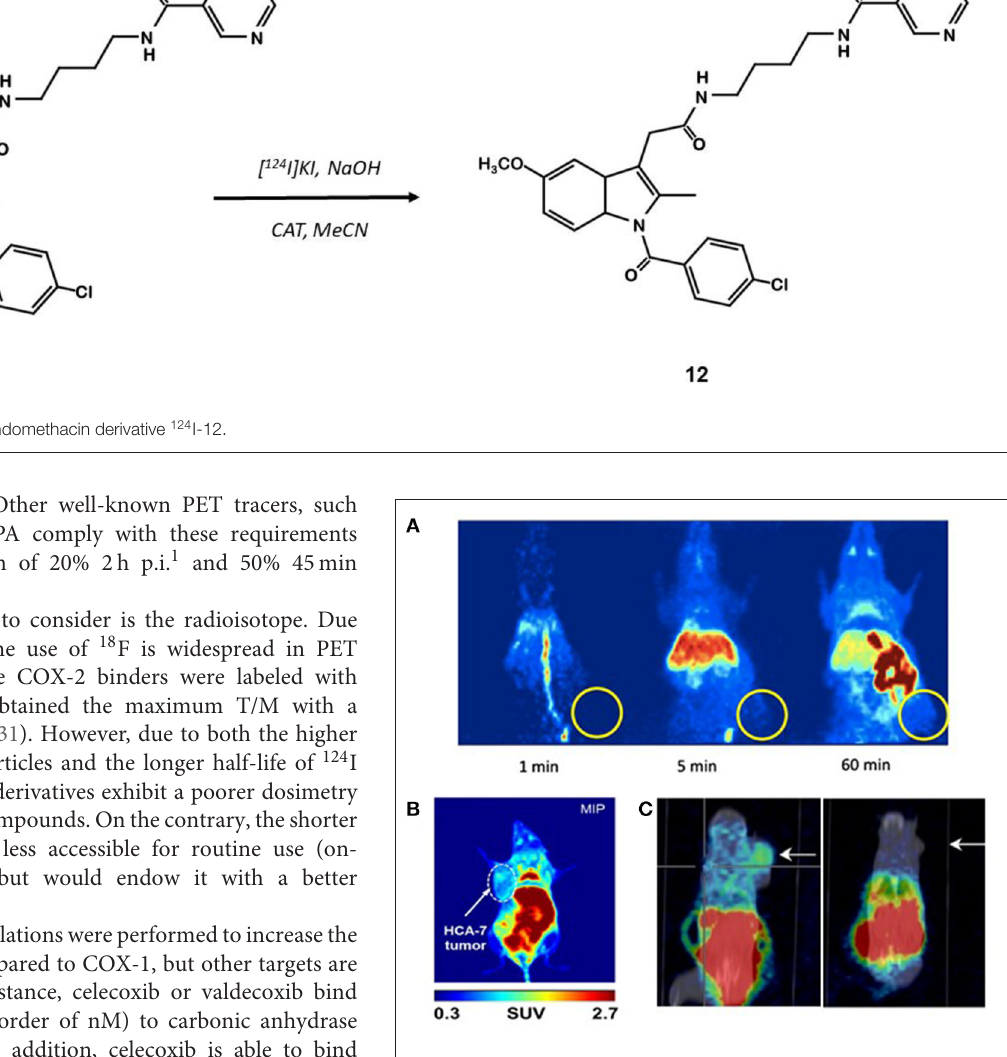
FIGURE 10 | microPET images of mice xenografted with human colorectal cancer cell lines after injection of a COX-2 specific radiotracer. (A) Kniess et al., 2012 (30): Maximum intensity projection (MIP) images at 1, 5, and 60min p.i. after a single IV injection of 18F-3 into HT-29 tumor-bearing (right flank) NMRI nu/nu mice. Authors concluded that 18 F- 3 was not promising. Reprinted from Bioorg Med Chem. 2012 Jun 1;20(11):3410–21, Radiosynthesis of a 18F-labeled 2,3-diarylsubstituted indole via McMurry coupling for functional characterization of cyclooxygenase-2 (COX-2) in vitro and in vivo . Kniess T, Laube M, Bergmann R, Sehn F, Graf F, Steinbach J, et al. Copyright (2012), with permission from Elsevier, license number 5067540791584. (B) Litchfield et al. (29): Maximum intensity projection (MIP) images at 60min p.i. of 18 F- 9 into HCA-7 tumor-bearing (left flank) BALB/c mice. Authors concluded that 18 F- 9 was promising. (C) Morgenroth et al. (31): µ PET/CT molecular imaging of COX-2 with 124 I- 12 in HT29 (left panel) and HCT-116 (right